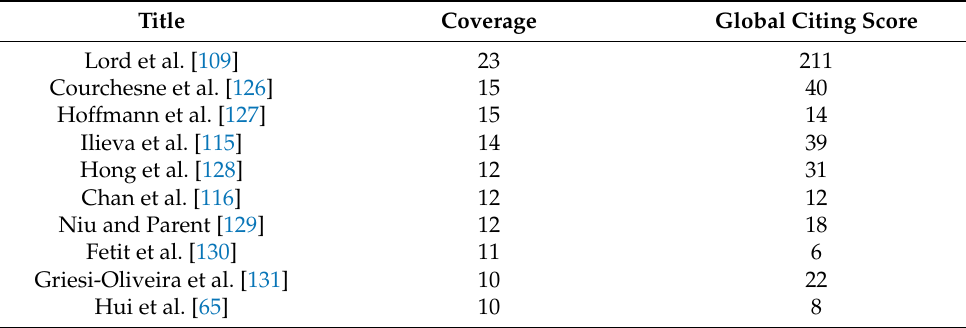
Table 8. Top 10 citing papers in Cluster #6 identified using